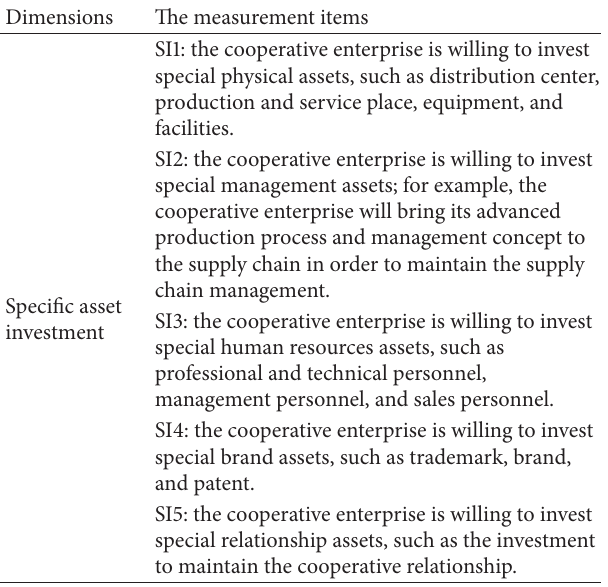
Specific asset investment